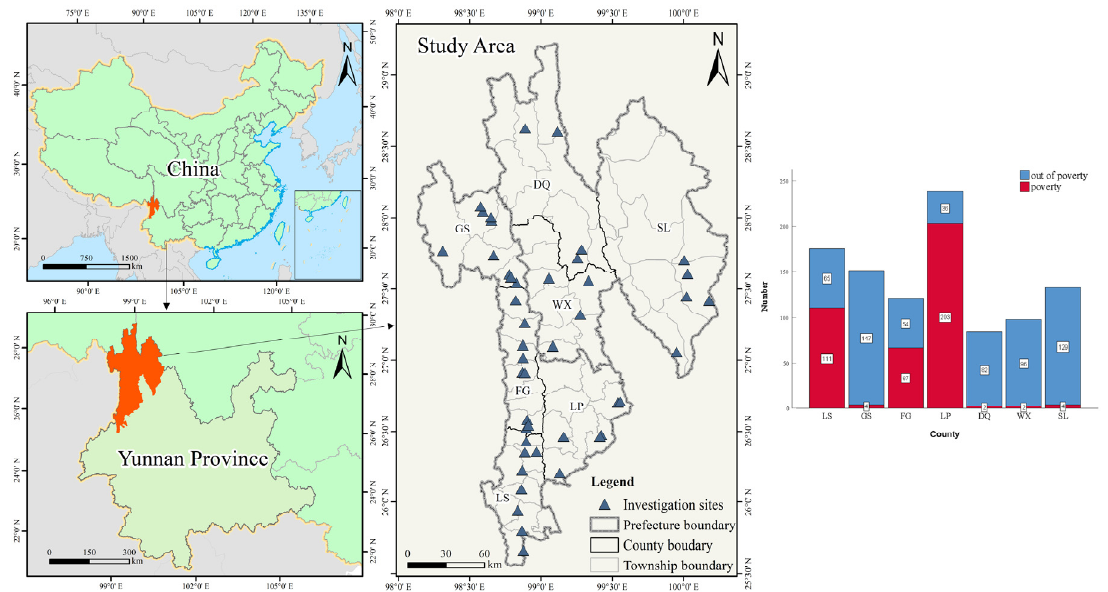
Figure 2. Location and basic condition of investigation sites Note: LS (Lushui City), GS (Gongshan County), FG (Fugong County), LP (Lanping County), DQ (Deqin County), WX (Weixi County), SL (Shangri-La City).